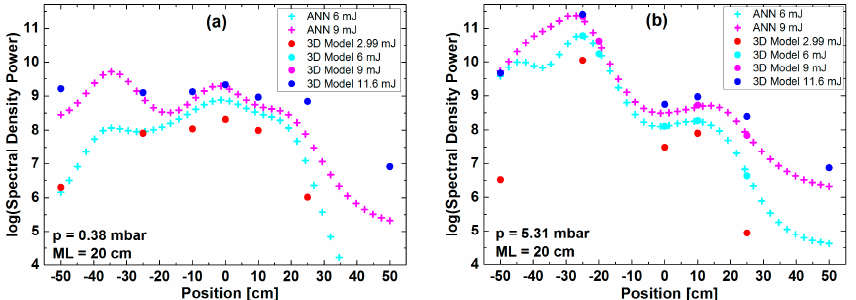
Figure 5. Harmonic yield as function of the gas cell position relative to the nominal focus. Dots are data obtained from the complete 3D simulations, “+” symbols are the results of the ANN predictions. Panel ( a ) synthesizes the results obtained for different laser pulse energies at the fixed parameter values p = 0.38 mbar and L med = 20 cm, i.e., at the cell end. Panel ( b ) shows the results obtained with p = 5.31 mbar and L med = 20 cm. Colors of the symbols dots and “+” are the same for the same energy. At the intermediate energies, 6 and 9 mJ, we have performed merely a few but computationally demanding 3D simulations and only with p = 5.31 mbar.